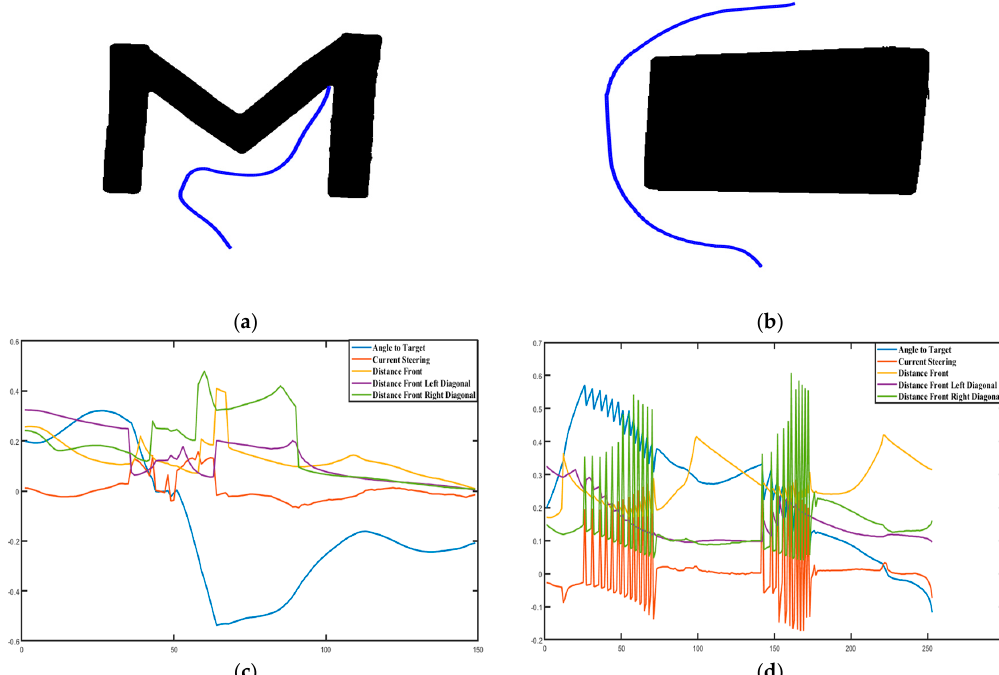
Figure 11. Test results for the second scenario (Figure 10) (collision detection ( a ), convex hull applied image and safe path generated from the image ( b ), the variable obtained from Figure 11a path generation when the robot goes to the goal ( c ), the variable obtained from Figure 11b path generation when the robot goes to the goal ( d